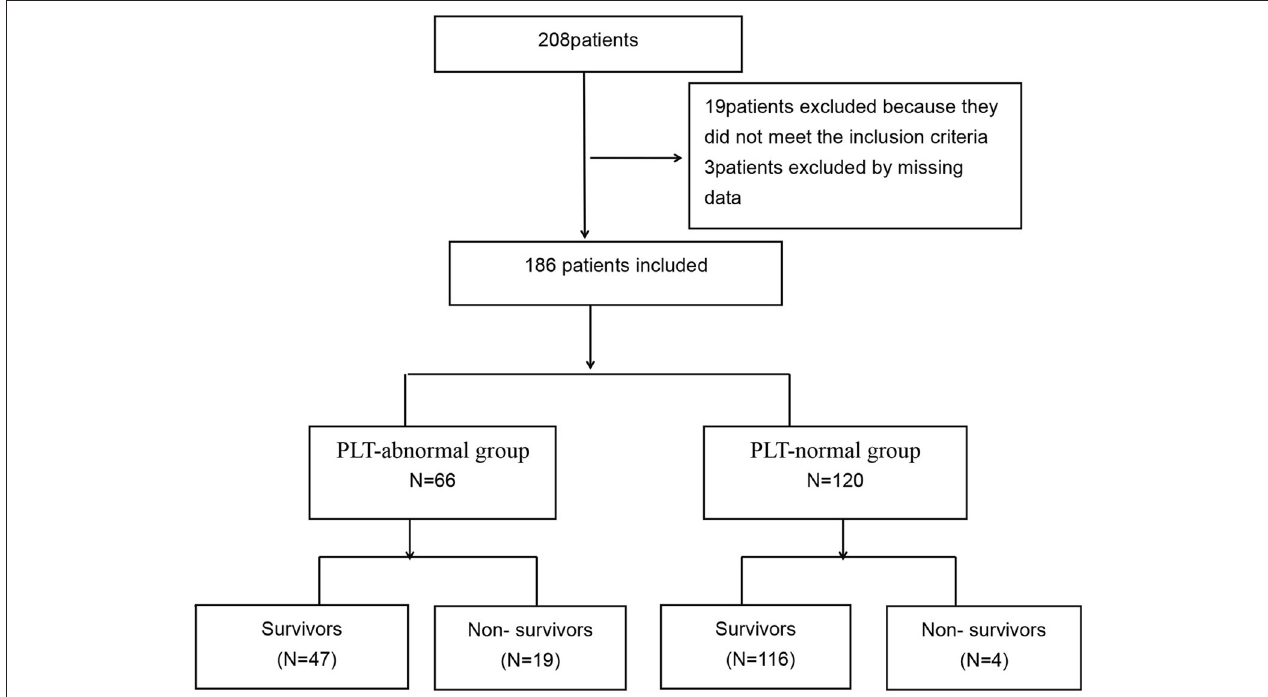
FIGURE 1 | Flowchart of all excluded and included